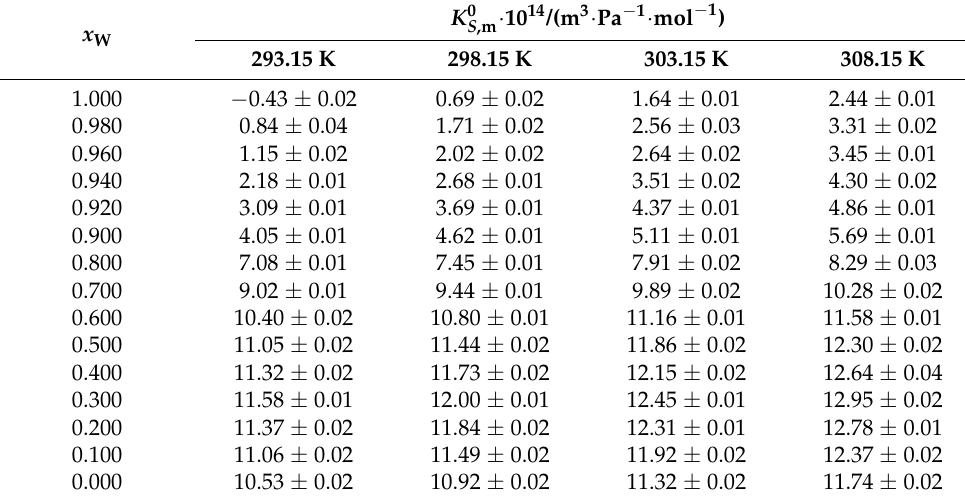
Table 6. Standard partial molar compression of pentaglyme in the DMF + W mixed solvent.